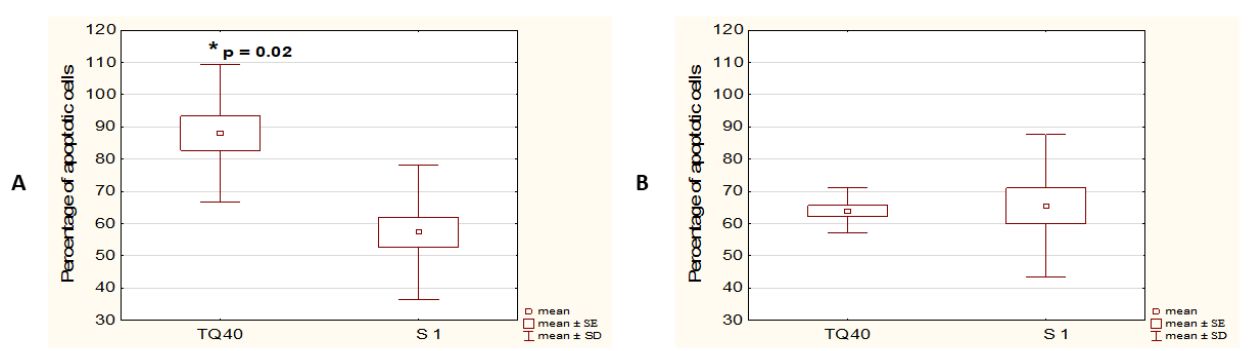
Figure 2. A375 cells showed higher sensitivity to 40 μ M TQ compared to staurosporine. Cytometric analysis of apoptosis in A375 ( A ) and WM9 ( B ) cells, treated with 40 μ M TQ, or 1 μ M staurosporine, for 48 h. * denotes a significant increase in the percentage of apoptotic cells compared to staurospor- ine control (Mann – Whitney U test); data are presented as mean ± SD; * p < 0.05 was considered to be statistically significant.